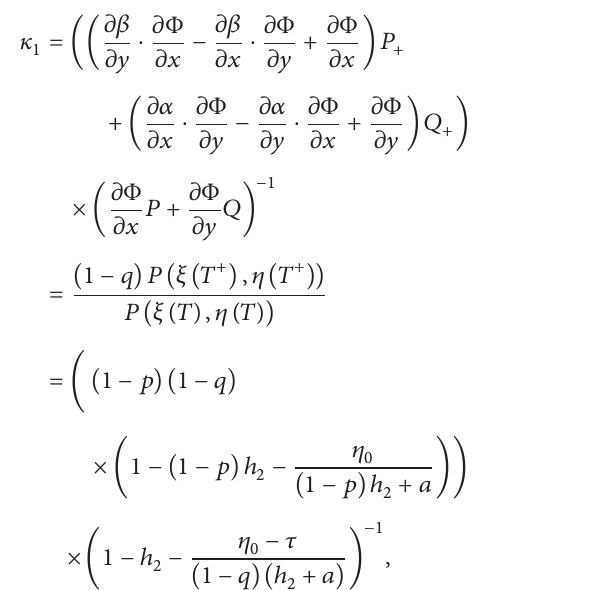
and hitting the impulsive set 𝑀 2 at 𝑄 1 (ℎ 2 , 𝑦 𝑄 of 𝑄 1 is 𝑄 + 1 (𝑥 𝑄 +